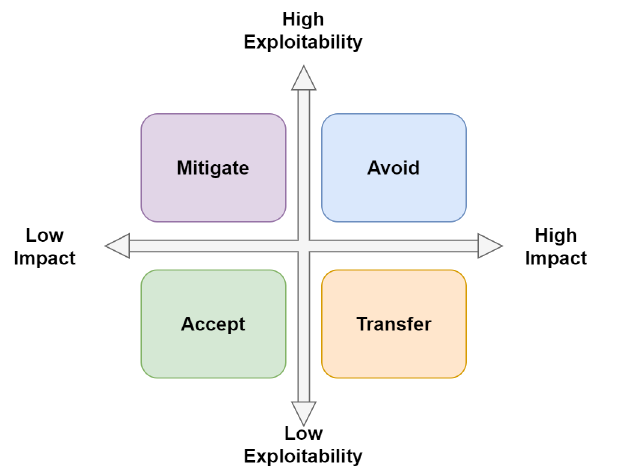
Figure 1. Risk treatment